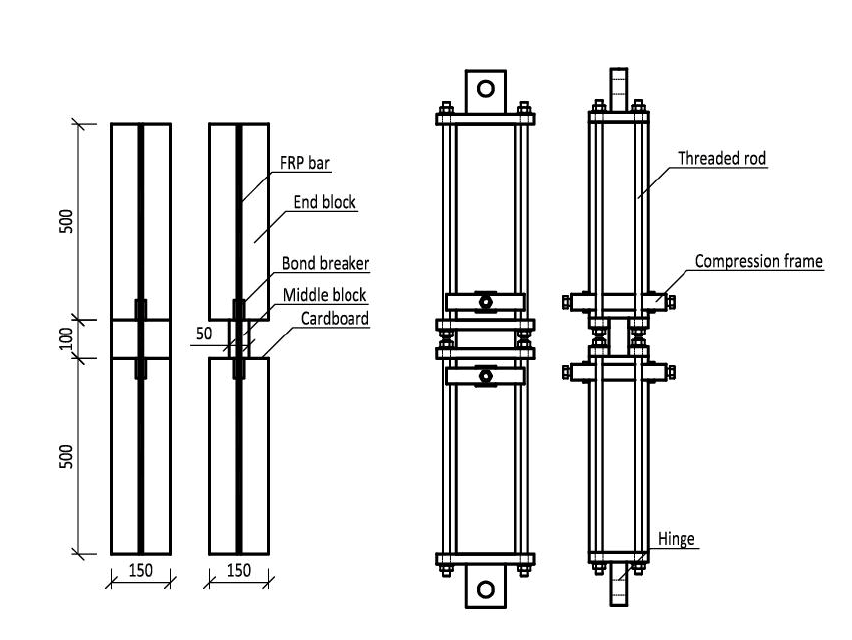
Figure 6. Bars encased in concrete - specimen